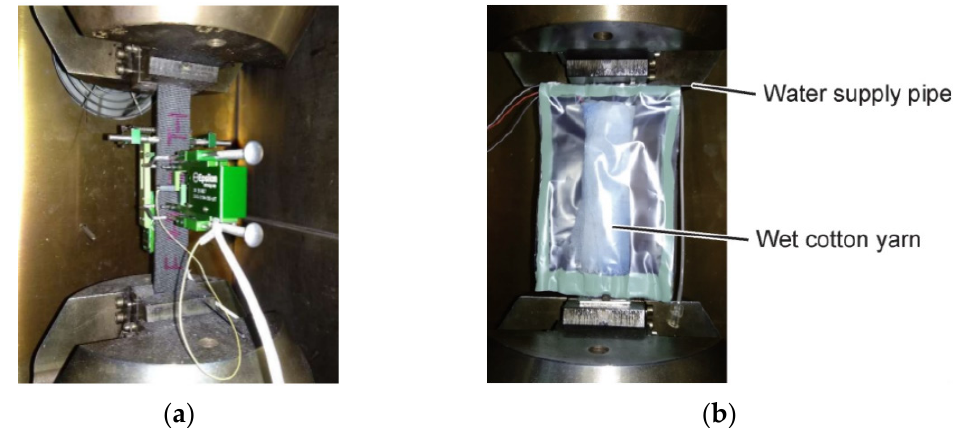
Figure 2. Test set for the tensile fatigue. ( a ) Test loading and measuring in RTD; ( b ) moisture retention of ETW test specimens.